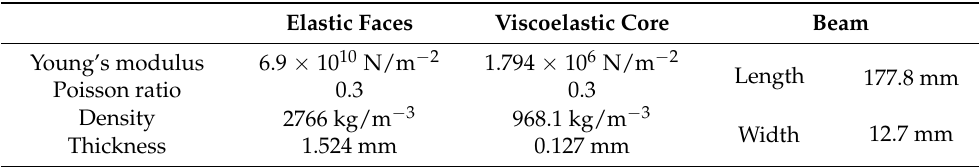
Table 2. Material and geometrical properties of the sandwich